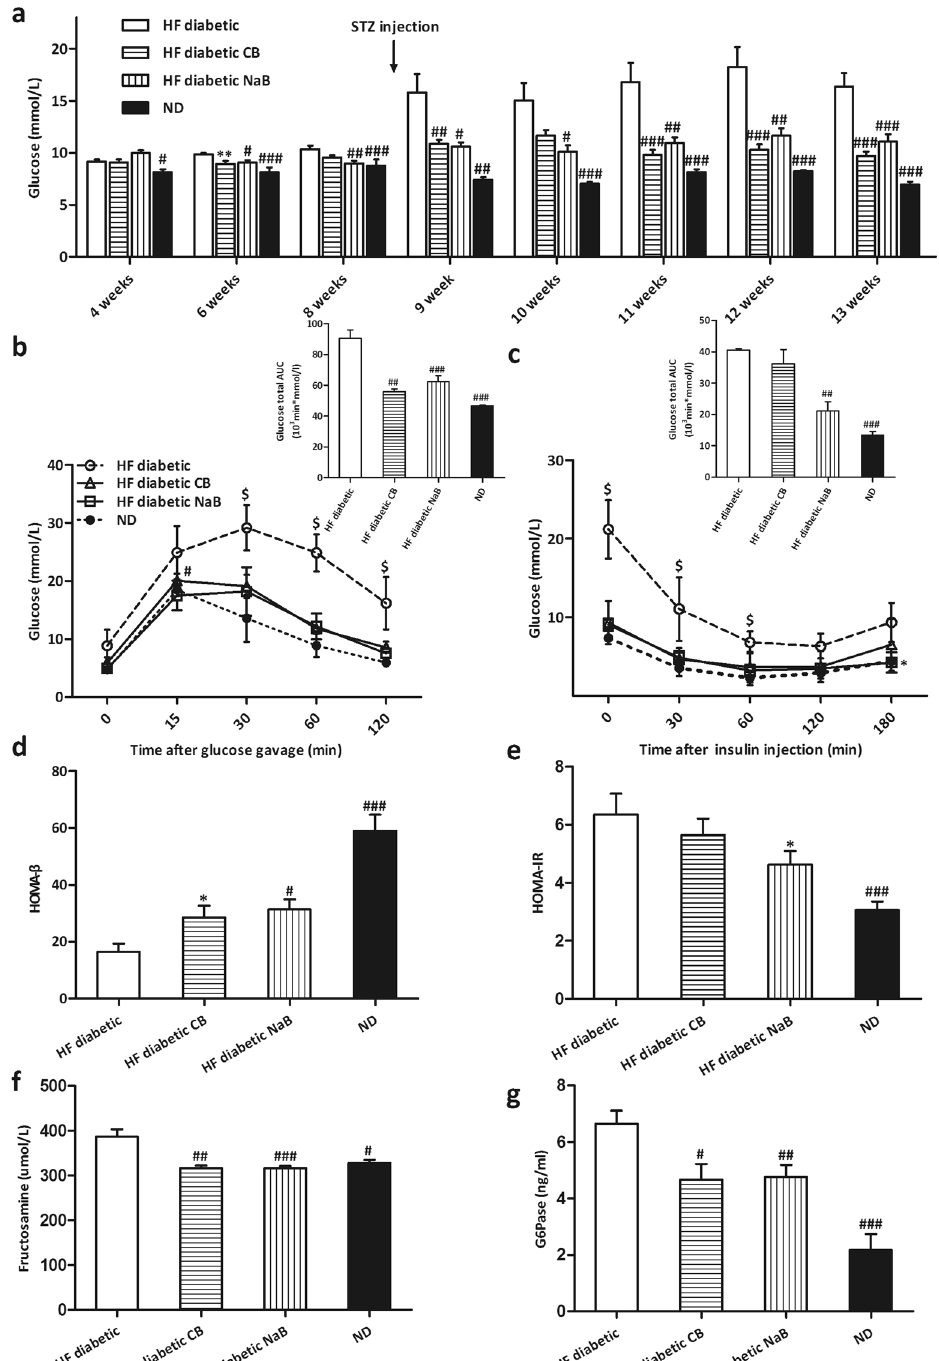
Figure 2. CB0313.1 improves glucose homeostasis and attenuates changes in serum diabetic biomarkers in HF diabetic mice. ( a ) Glucose was tested after 6 h fasting. Glucose ( b ) and insulin ( c ) tolerance tests with total glucose area under the curve (AUC) were performed 4 weeks after STZ injection. ( d ) Beta cell sensitivity: HOMA- β = 20 × Fasting insulin (mIU/L)/[Fasting blood glucose (mmol/L) − 3.5]. ( e ) Insulin resistance: HOMA-IR = fasting blood glucose (mmol/L) × fasting insulin (mIU/L)/22.5. ( f ) Serum fructosamine. ( g ) Serum G6Pase. Data are mean ± SEM (n = 3–12 mice per group). #, ##, ### p < 0.05, p < 0.01, p < 0.001 vs HF diabetic control by one-way ANOVA followed by the indicated post hoc test. * , ** , *** p < 0.05, p < 0.01, p < 0.001 vs HF diabetic control by t -test. $ p < 0.05 vs all groups. HF diabetic: high fat diet and streptozotocin, HF diabetic CB: high fat diet and streptozotocin plus CB0313.1, HF diabetic NaB: high fat diet and streptozotocin plus NaB, ND: Normal